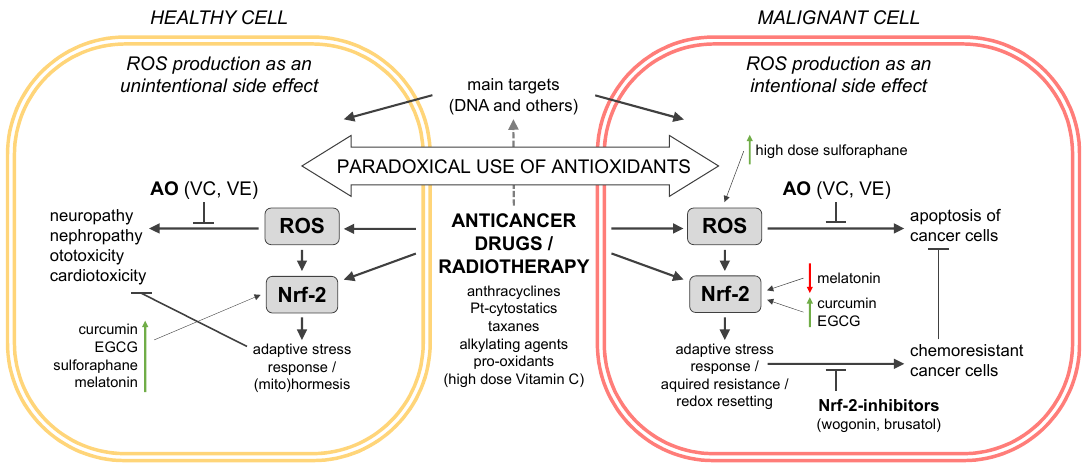
Figure 2. Chemo- and radiotherapy-mediated ROS induces apoptosis in malignant cells and side effects in healthy cells at the same time. The paradoxical use of antioxidants (AOs) might diminish side effects, but could also lead to chemo-resistant cancer cells (own illustration). VC: vitamin C; VE: Vitamin E; EGCG: epigallocatechin-3-gallate; ROS: reactive oxygen species; Nrf-2: nuclear erythroid-related factor-2; ↑ increase, ↓ decrease.